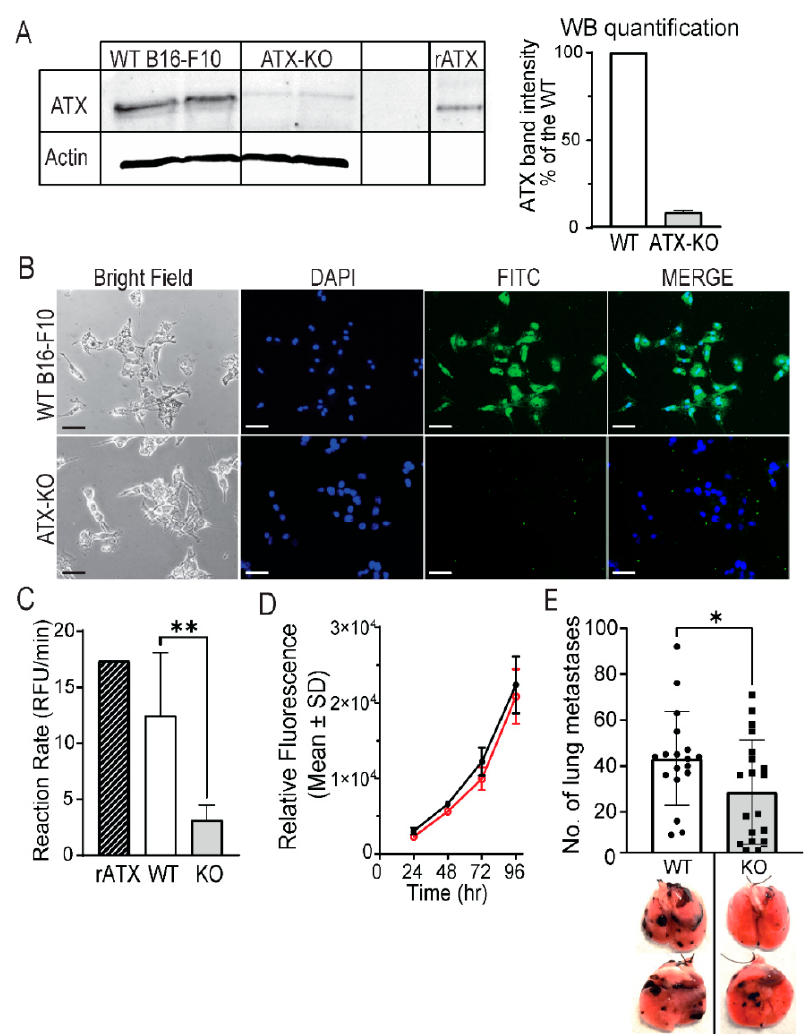
Figure 2. ATX derived from B16-F10 partially controls the progression of lung metastasis. ( A ) Western blot analysis of cell lysates performed in two technical repeats of WT B16-F10 cells (lanes 1 and 2, respectively) and ATX-KO B16-F10 cells (lanes 3 and 4, respectively). Recombinant ATX (rATX, lane 6) was used as a positive control. Densitometric quantification of the ATX band showed an average 91% decrease in ATX expression in ATX-KO B16-F10 cell lysate compared to WT B16-F10 cells (mean ± SD of 4 independent experiments). Cell lines were cultured for 18 h in serum-free medium before lysates were harvested. One hundred micrograms of protein was loaded into an 8% SDS-PAGE. ( B ) ATX immunofluorescence staining in WT and ATX-KO B16-F10 cells. Cells were stained for ATX (green) using the 4F1 antibody at 1:100 dilution, with DAPI nuclear counterstain (1:5000). Upper panels show the staining of WT B16-F10 cells, whereas lower panels show the staining of ATX-KO B16-F10 cells. Scale bars represent 100 µ m (20 × magnification). ( C ) Quantification of ATX activity in concentrated conditioned medium (CCM) from WT and ATX-KO B16-F10. Crosshatched bar represents 10 nM recombinant ATX (rATX) positive control, white bar corresponds to the ATX activity in the CCM of WT B16-F10 cells ( n = 5), and gray bar is the activity measured in CCM of ATX-KO B16-F10 cells ( n = 5). ATX-KO B16-F10 cells present a 74.3% decrease in ATX activity compared to WT B16-F10 cells (Mann–Whitney, ** p = 0.0079). ( D ) Comparison of the growth rate between WT (black) and ATX-KO (red) B16-F10 performed in six replicates; representative of three independent experiments. ( E ) Metastatic foci in the lungs of C57BL/6 mice inoculated with 1 × 10 5 WT B16-F10 cells (white bar, n = 18) or ATX-KO B16-F10 cells (gray bar, n = 20), and representative lung pictures from this experiment (below). Mice inoculated with ATX-KO B16-F10 cells showed a 34% decrease in lung metastases (unpaired t -test, * p = 0.04, data from 2 independent